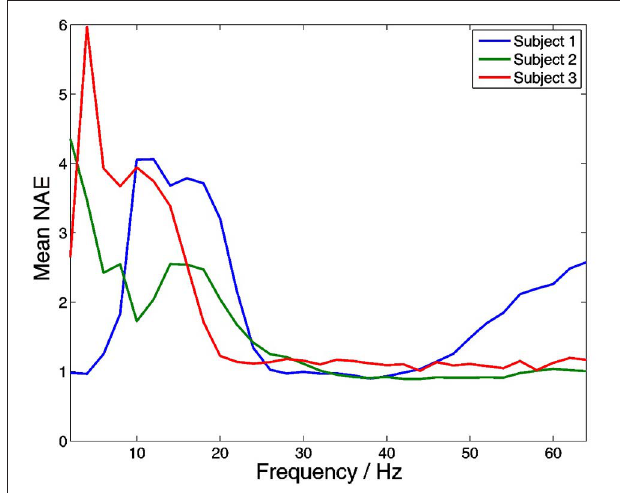
FIGURE 11 | Distributions of within-frequency amplitude co-modulation between the thalamus and PFC. Mean coupling was positive in all subjects at all frequencies, and strongest at lower